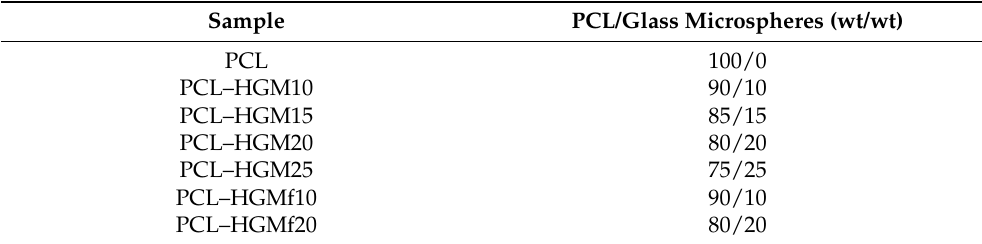
Table 1. Composition of the PCL-based composites.